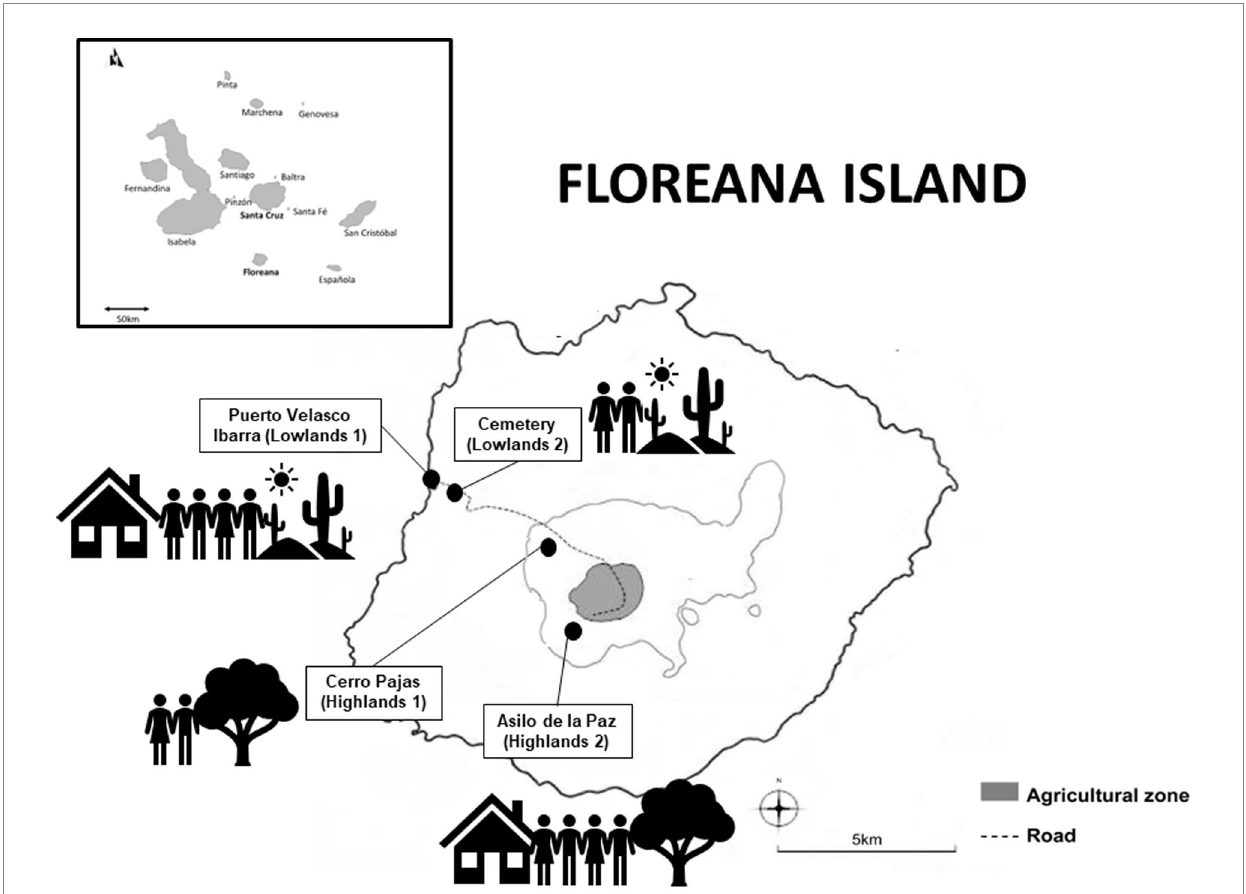
FIGURE 1 Map illustrating the urban gradient used in this study. The gradient started in the lowland town of Puerto Velasco Ibarra (lower rainfall, higher level of human activity; referred to as Lowlands 1), extended from the town edge through the lowland arid zone (lower rainfall, lower level of human activity; referred to as Lowlands 2), along the road to the highland forest trail to Cerro Pajas Volcano (higher rainfall, lower level of human activity; referred to as Highlands 1), and finished at the highland tourist destination of Asilo de la Paz (higher rainfall, higher level of human activity; referred to as Highlands